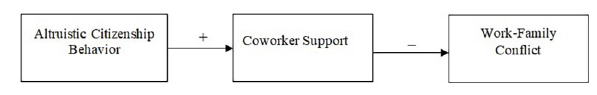
FIGURE 1 | Theoretical